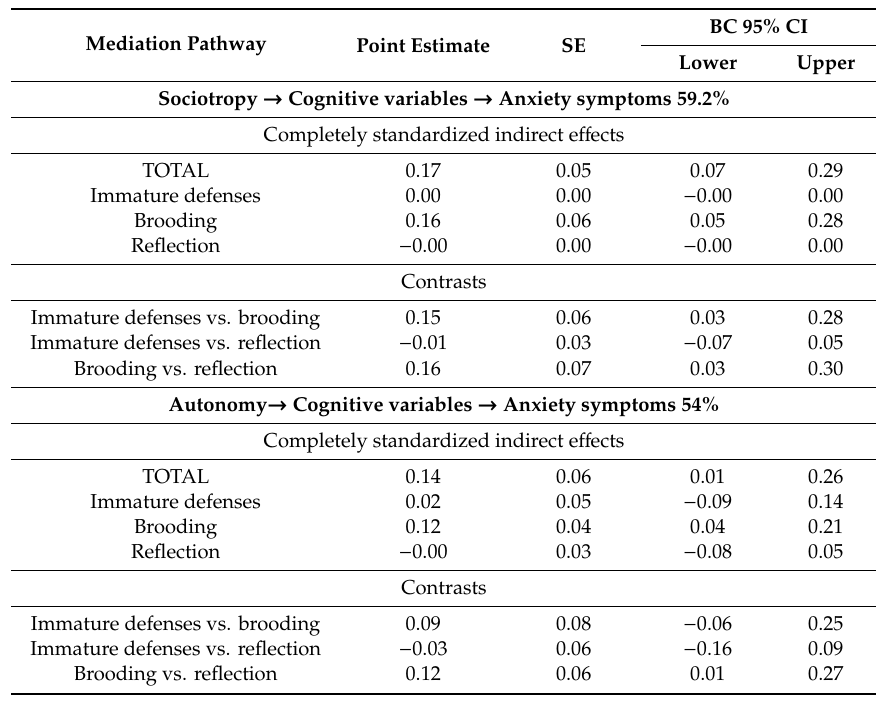
Table 4. Results of multiple mediation analysis of the relation between sociotropy and autonomy, respectively, and anxiety symptoms in patients with MDD ( n = 119).